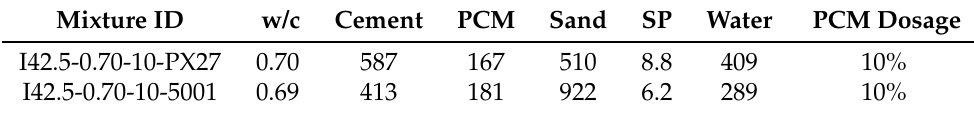
Table 7. Mortar mixtures compositions expressed as (kg/m 3